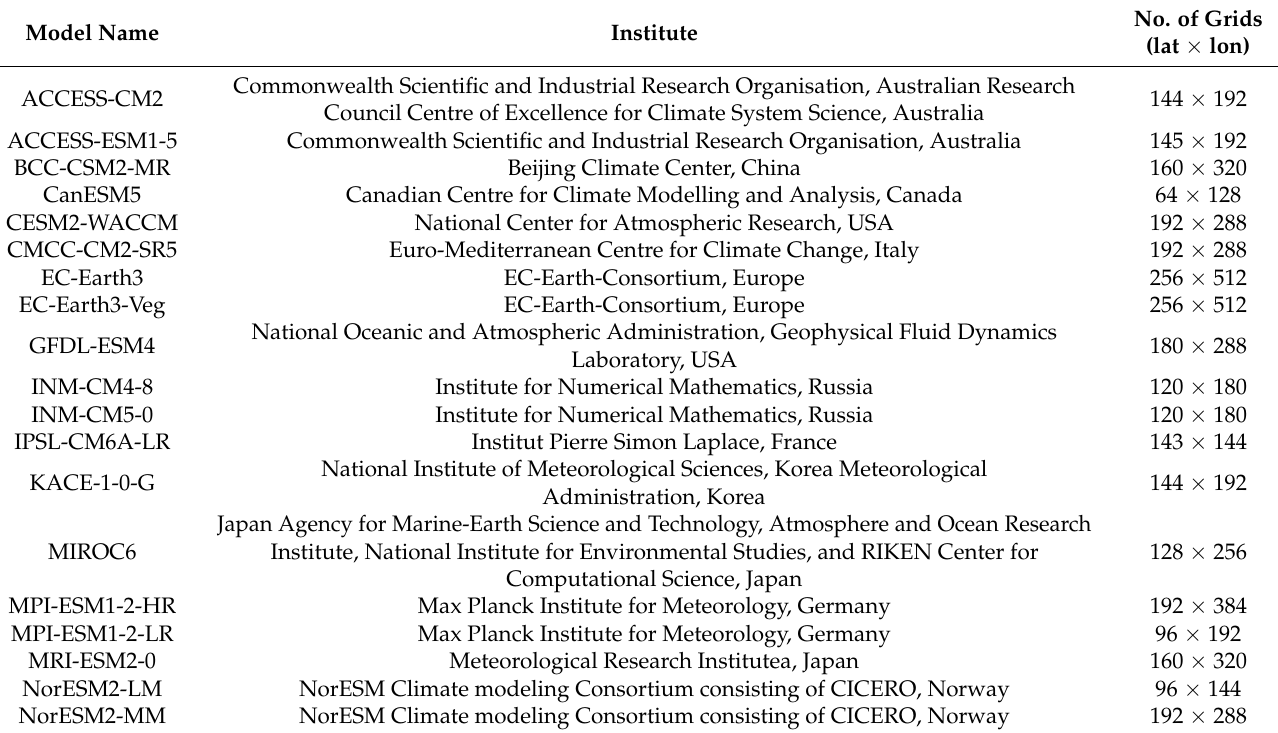
Table 1. Information on the 19 CMIP6 climate models used in this study.